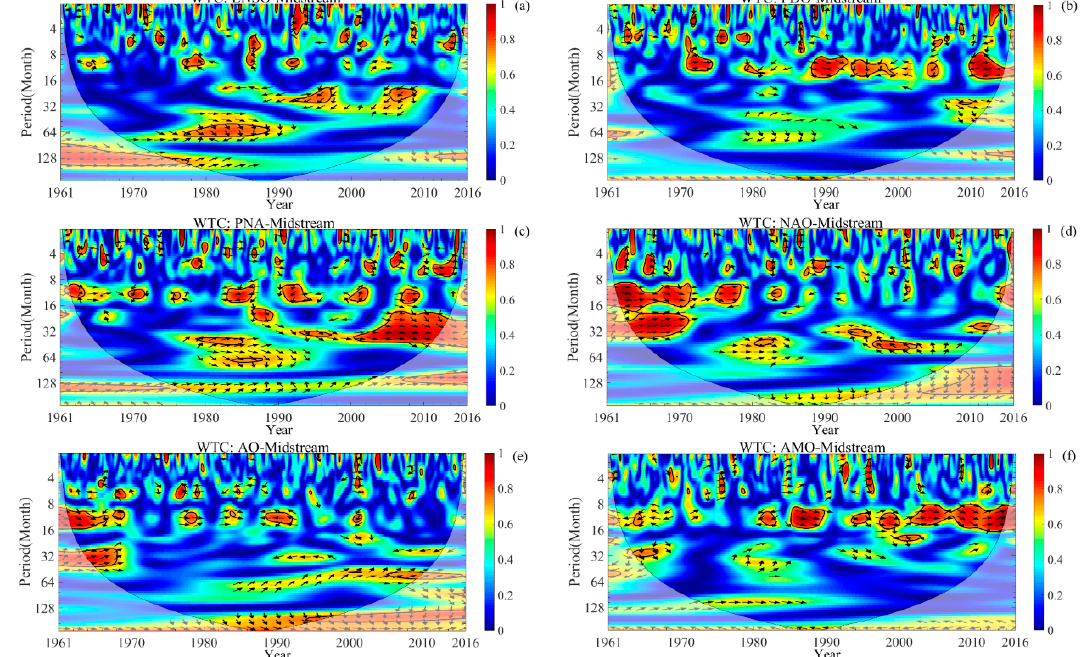
Figure 9. The wavelet coherence spectra between monthly observed average precipitation and El Niño-Southern Oscillation (ENSO) ( a ), Pacific Decadal Oscillation (PDO) ( b ), Pacific North American teleconnection pattern (PNA) ( c ), North Arctic Oscillation (NAO) ( d ), Atlantic Oscillation (AO) ( e ), and Atlantic Multidecadal Oscillation (AMO) ( f ) indices covering 1961–2016 in the middle Heihe River Basin (MHRB). The 5% significance level against red noise is exhibited as a thick contour, and the relative phase relationship is denoted by arrows.